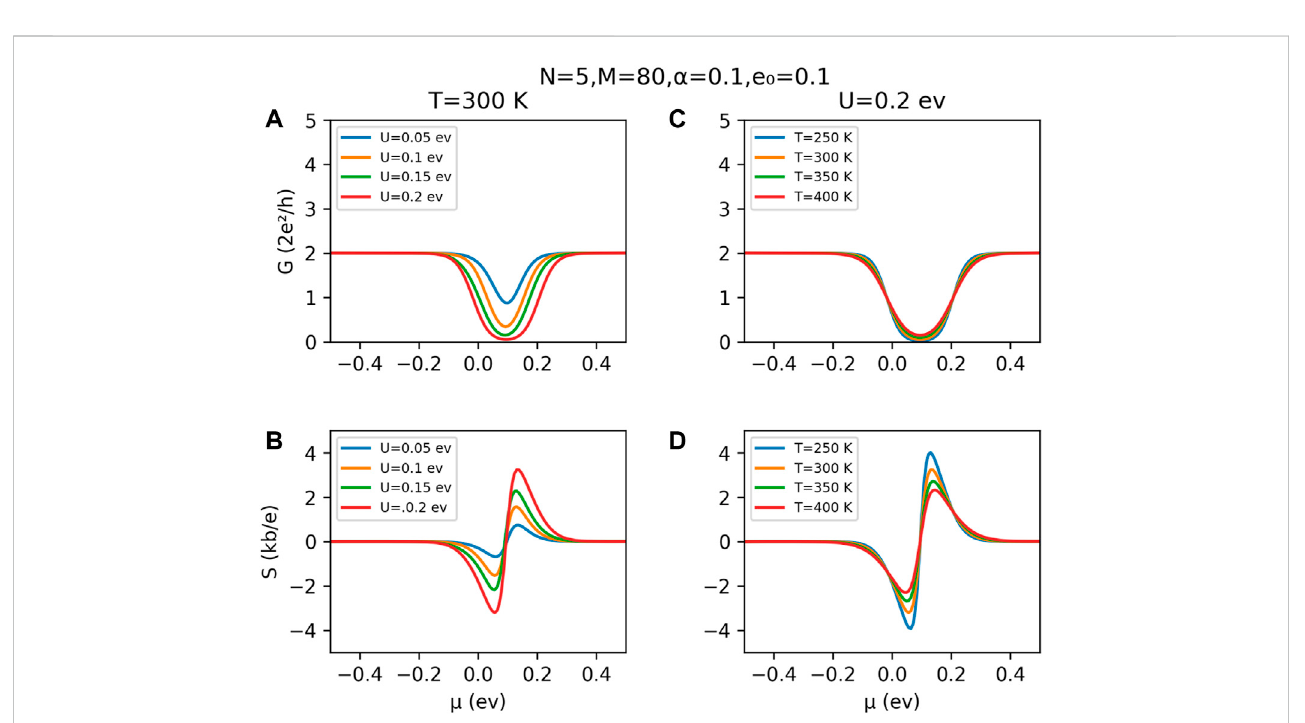
FIGURE 3 Electronic conductance and thermopower for an A-SNR of width N = 5 and length L = 80. In panels (A) and (B), we have fi xed the temperature in 300K, and then variations of the external potential intensity, whereas in panels (C) and (D), we have considered variations of the temperature of the heterostructure.